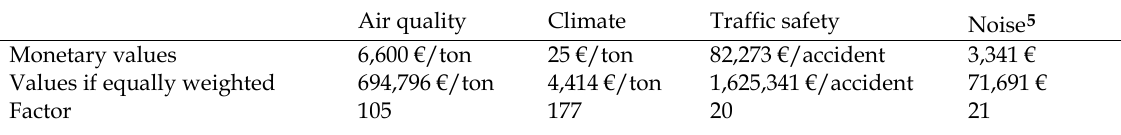
Table 5. Correction factor monetary values if equally weighted with travel time costs Air quality Climate Traffic safety Noise 5 Monetary values 6,600 €/ton 25